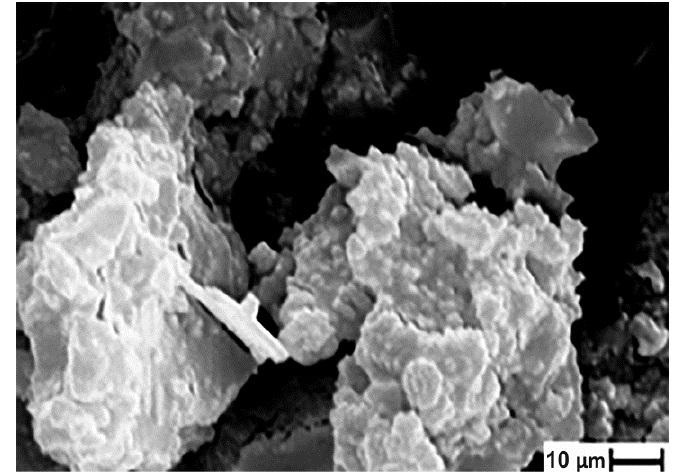
Figure 5. SEM image of the synthesized titanium phosphate .